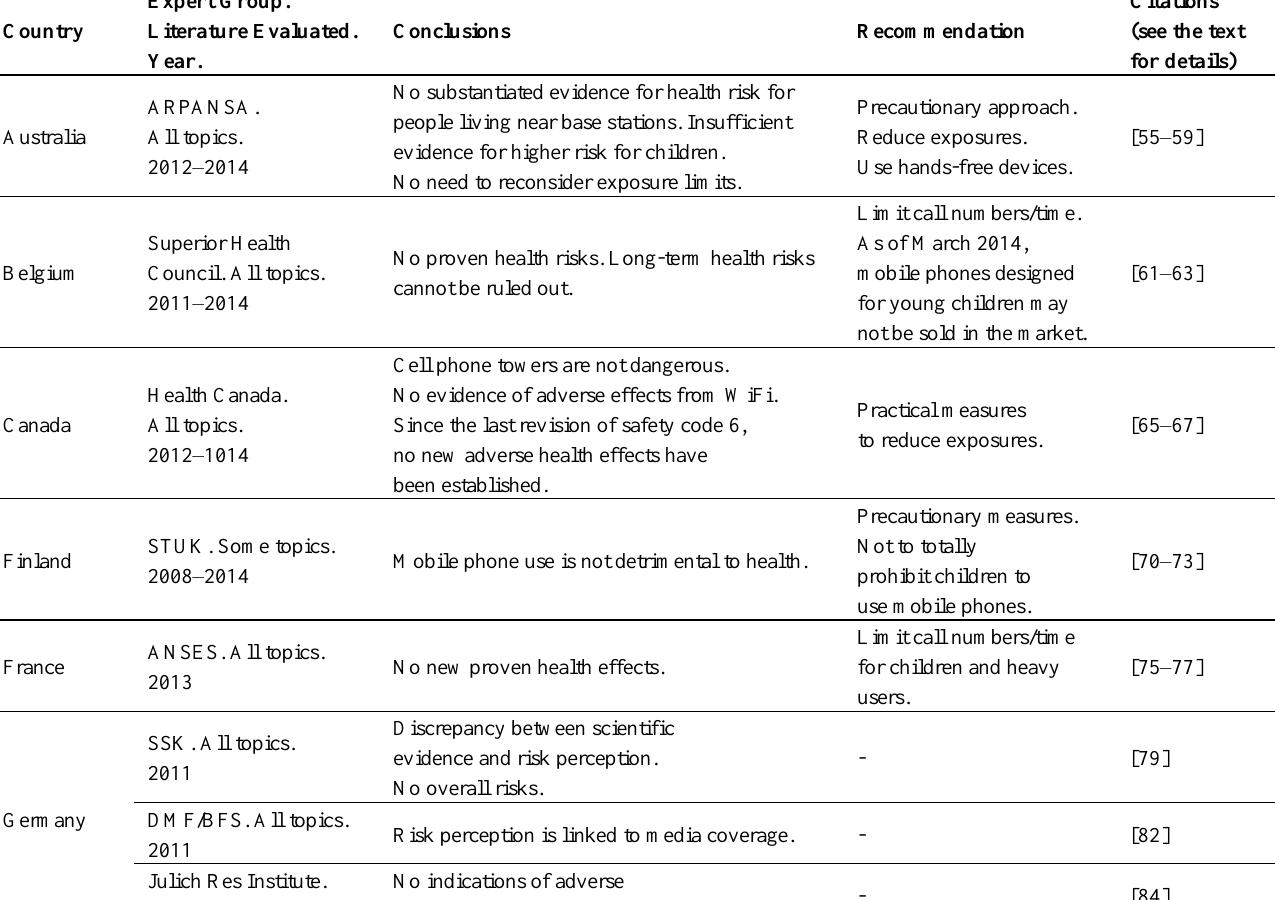
Table 2. Summary of international expert group evaluations on the biological and health effects reported in all animal and human cells (including human epidemiological investigations) exposed in vitro and in vivo to non-ionizing radiofrequency